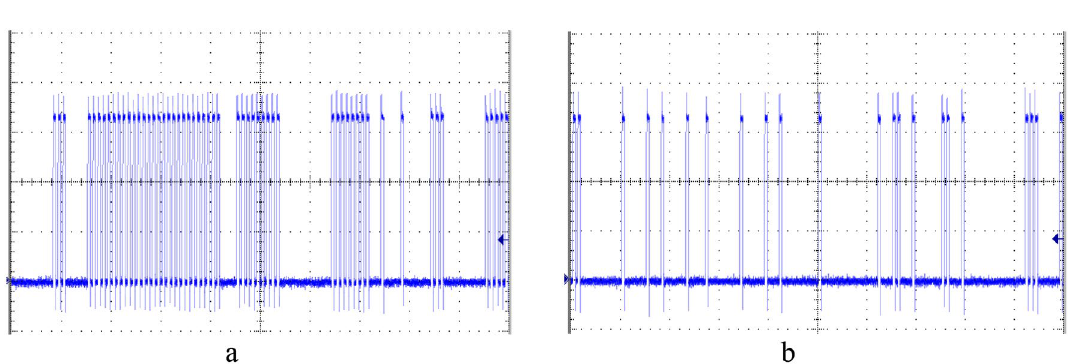
Figure 14. Oscillograms of output RPTs from division circuits DIV3 (a) and DIV2 (b) , for input values p 0 = 0.3 and p 1 =